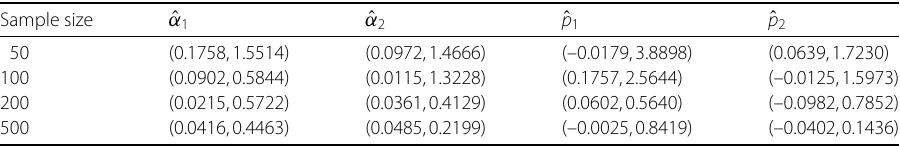
Table 3 Bias and SE of the parameters in Models II with λ = 1